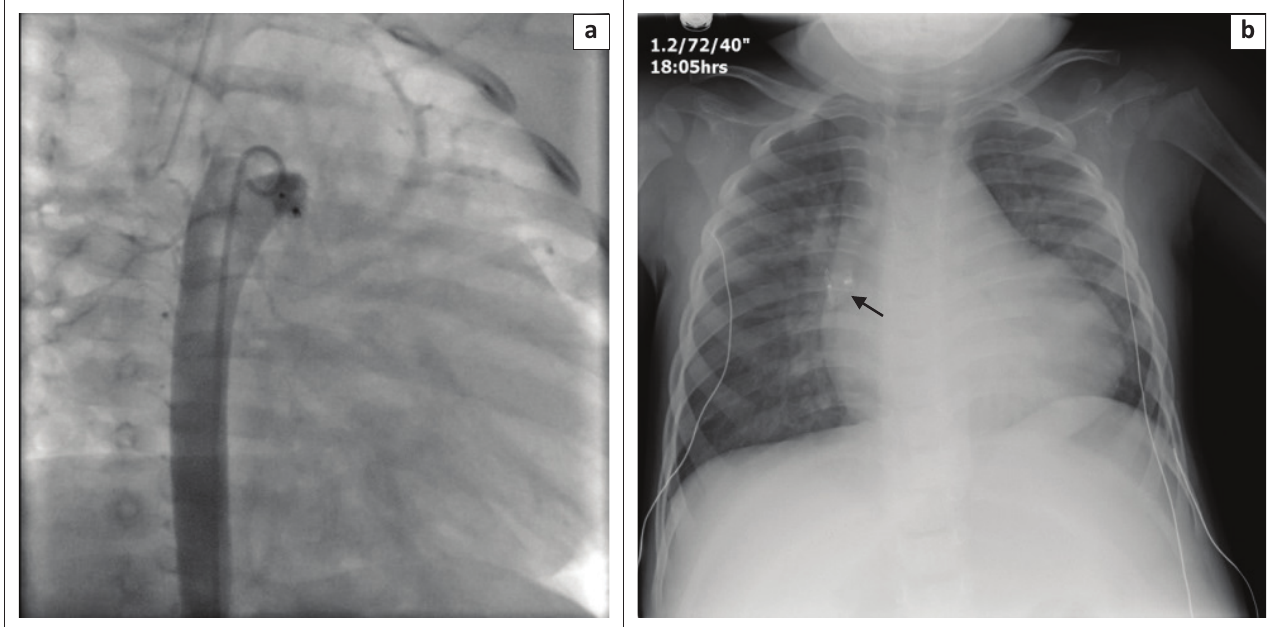
FIGURE 21: Chest radiographs showing a normally positioned Amplatzer septal occluder (arrow) in a 4-year-old girl with a history of a secundum atrial septal defect. Note that the ASO is projecting over the right lateral margins of the T8 vertebral body on the frontal view (a) and located anterior to the hilar-caval line on the lateral view (b). 16